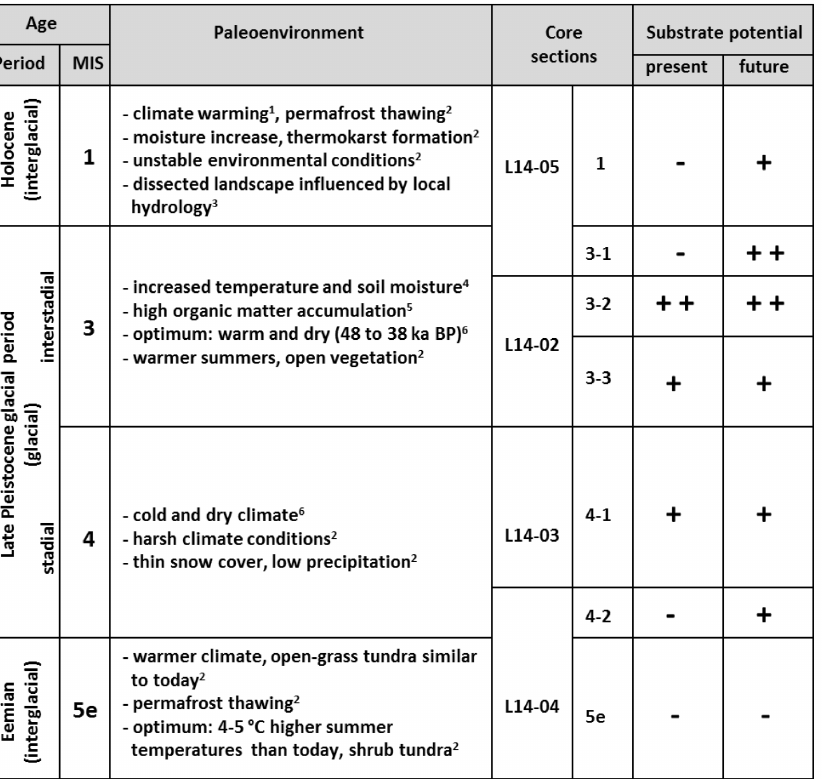
Table 2. Schematic summary compiling the assigned ages (time period and marine isotope stage (MIS) classification) of the core material from Bol’shoy Lyakhovsky Island based on Andreev et al. (2004, 2009) and Wetterich et al. (2009, 2014), the paleoenvironmental information on the different time intervals ( 1 Schirrmeister et al., 2002; 2 Andreev et al., 2009, 3 Grosse et al., 2007; 4 Sher et al., 2005; 5 Schirrmeister et al., 2011a; 6 Wetterich et al., 2014), the core sections, and the assessment of the organic matter (OM) from different ages to act as a substrate provider for microbial greenhouse gas production (present (free acetate) and future (bound acetate) substrate potential).